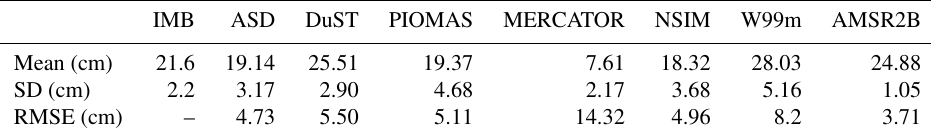
Table 2. Statistics of the comparison with IMB data and the various snow depth products considering data acquired during